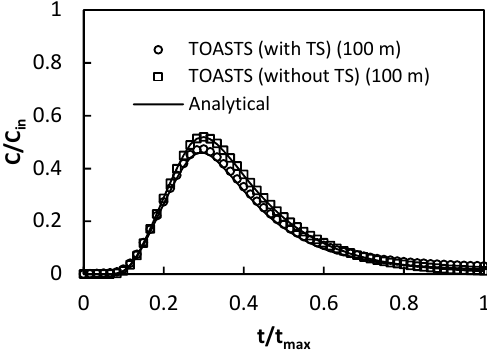
Figure 4. Results of the TOASTS model verification by the analyt- ical solution for Heaviside boundary condition ( α =